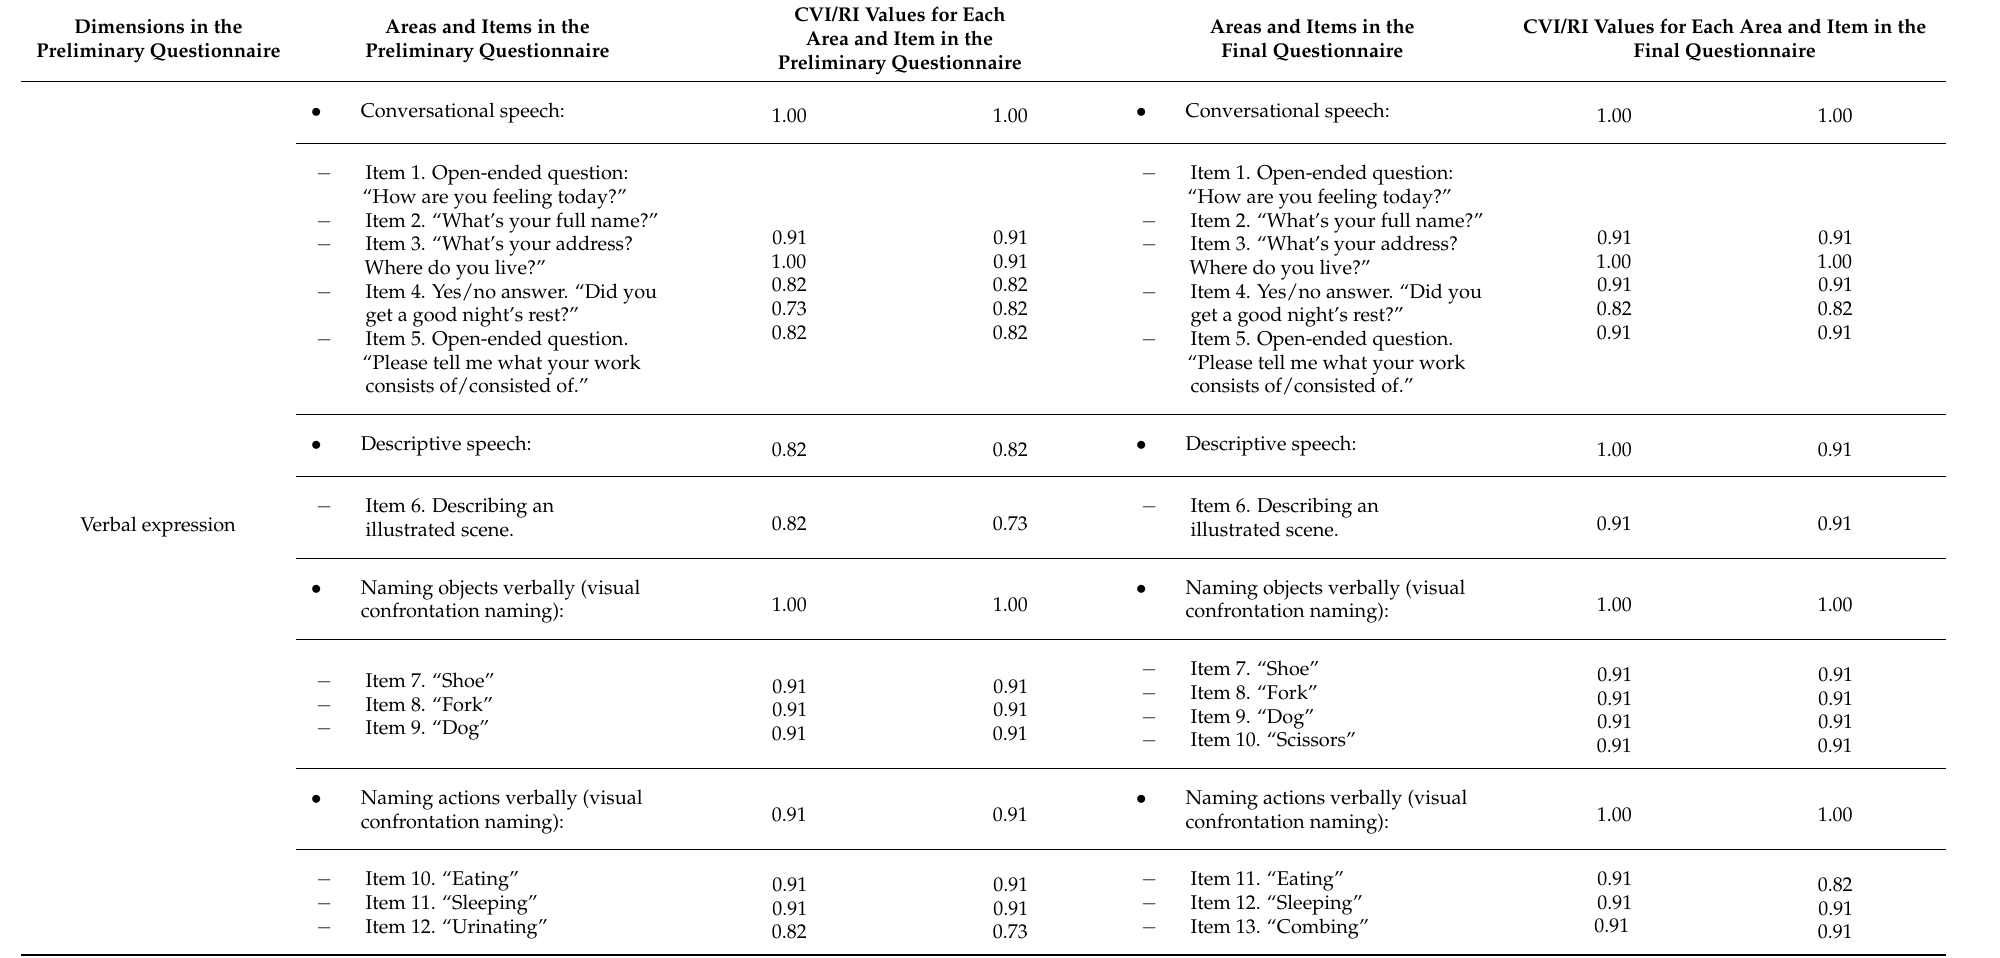
Areas and Items in the CVI/RI Values for Each Area and Item in the Final Questionnaire Final Questionnaire